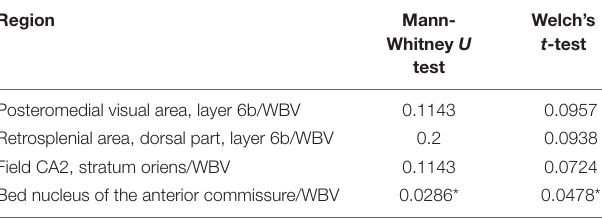
TABLE 5 | Results of each statistical test of Figure 4